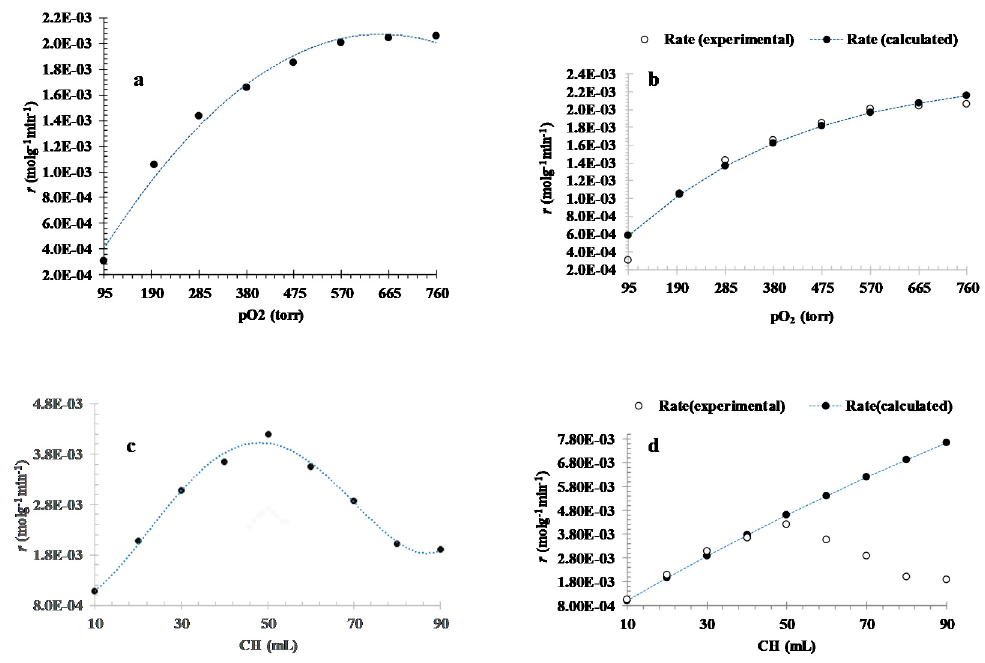
Figure 6. Kinetics of CH oxidation ( a ); effect of oxygen partial pressure on the rate of CH conversion using a MnFe 2 O 4 catalyst, ( b ); comparison of experimental and calculated rates from non-linear least-square fit for oxygen partial pressure, ( c ); effect of change in CH volume on the rate of reaction, ( d ); correlation between experimental and calculated rates for CH volume.